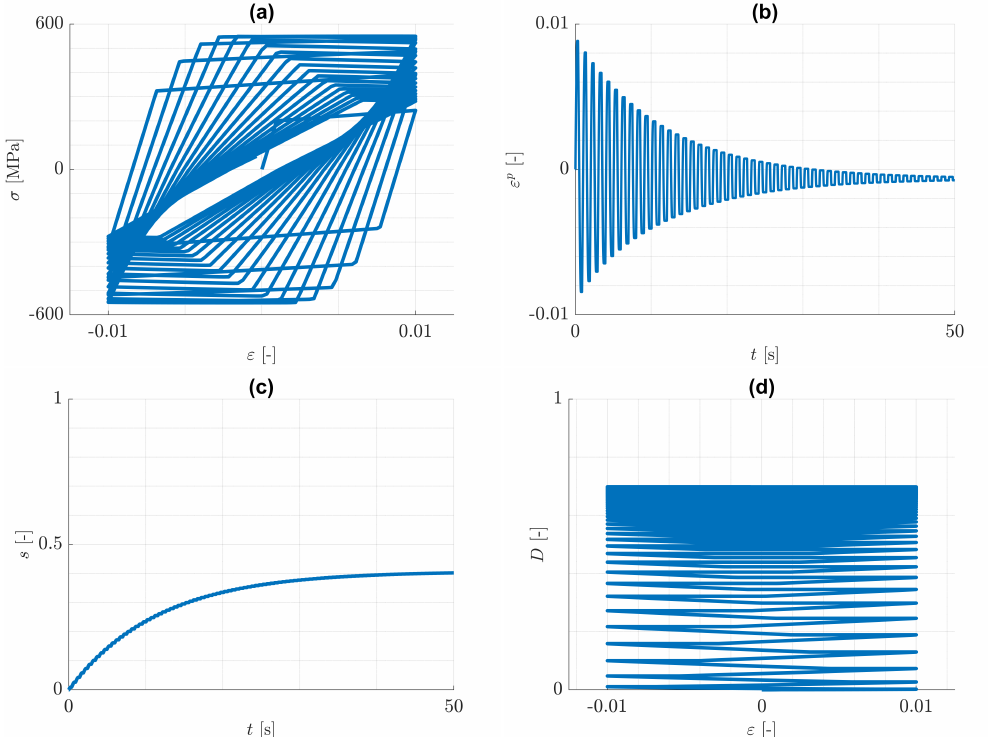
Figure 6. Pure isotropic hardening: cyclic, uniaxial tension/compression loading with ε 0 = 0,01. Pre-